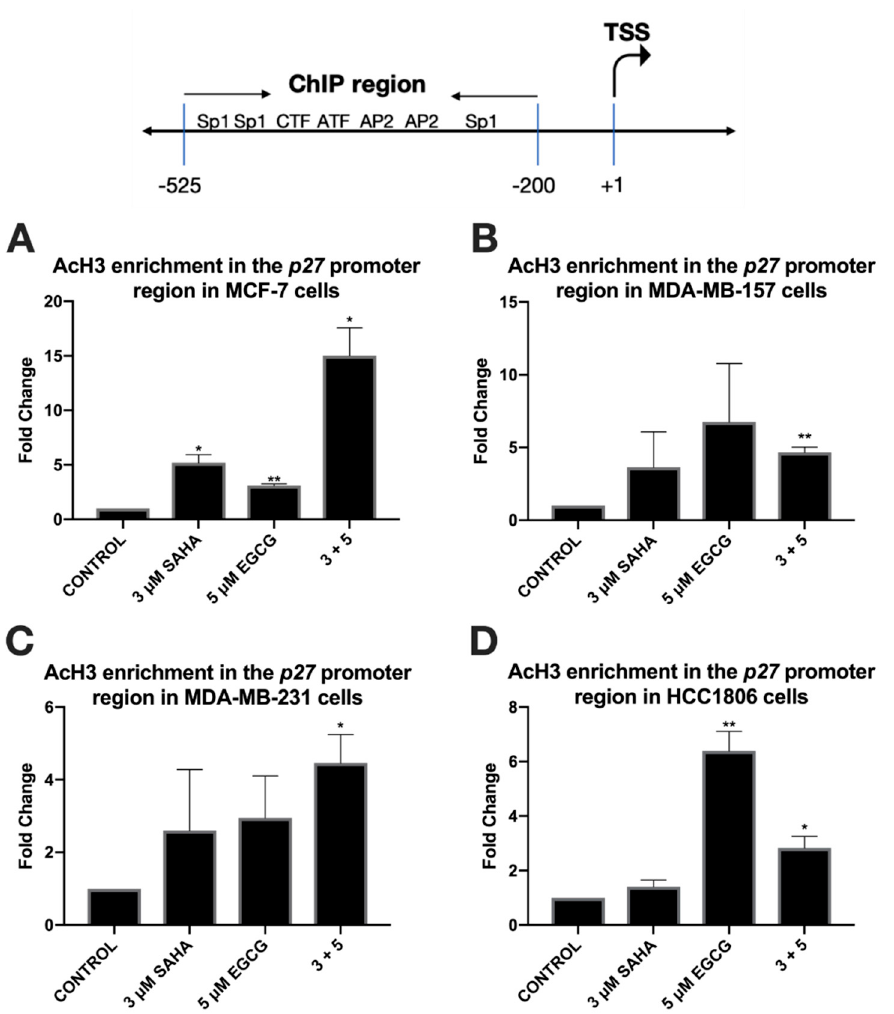
Figure 6. Acetylated histone H3 is enriched in the promoter region of p27 with the combination treatment of SAHA and EGCG. ( A ) ChIP qRT-PCR analysis using AcH3 antibodies (Millipore Sigma, Burlington, MA, USA) and p27 promoter primers (Integrated DNA Technologies, Coralville, IA, USA) was performed with a ChIP kit (Abcam, Cambridge, MA, USA) in MCF-7 cells after 3-day treatments with the indicated compounds ( n = 3). ( B – D ) The same was done in the MDA-MB-157, MDA-MB-231, and HCC1806 triple-negative cell lines. Histone H3 antibody (Abcam) was used as a positive control for comparison.